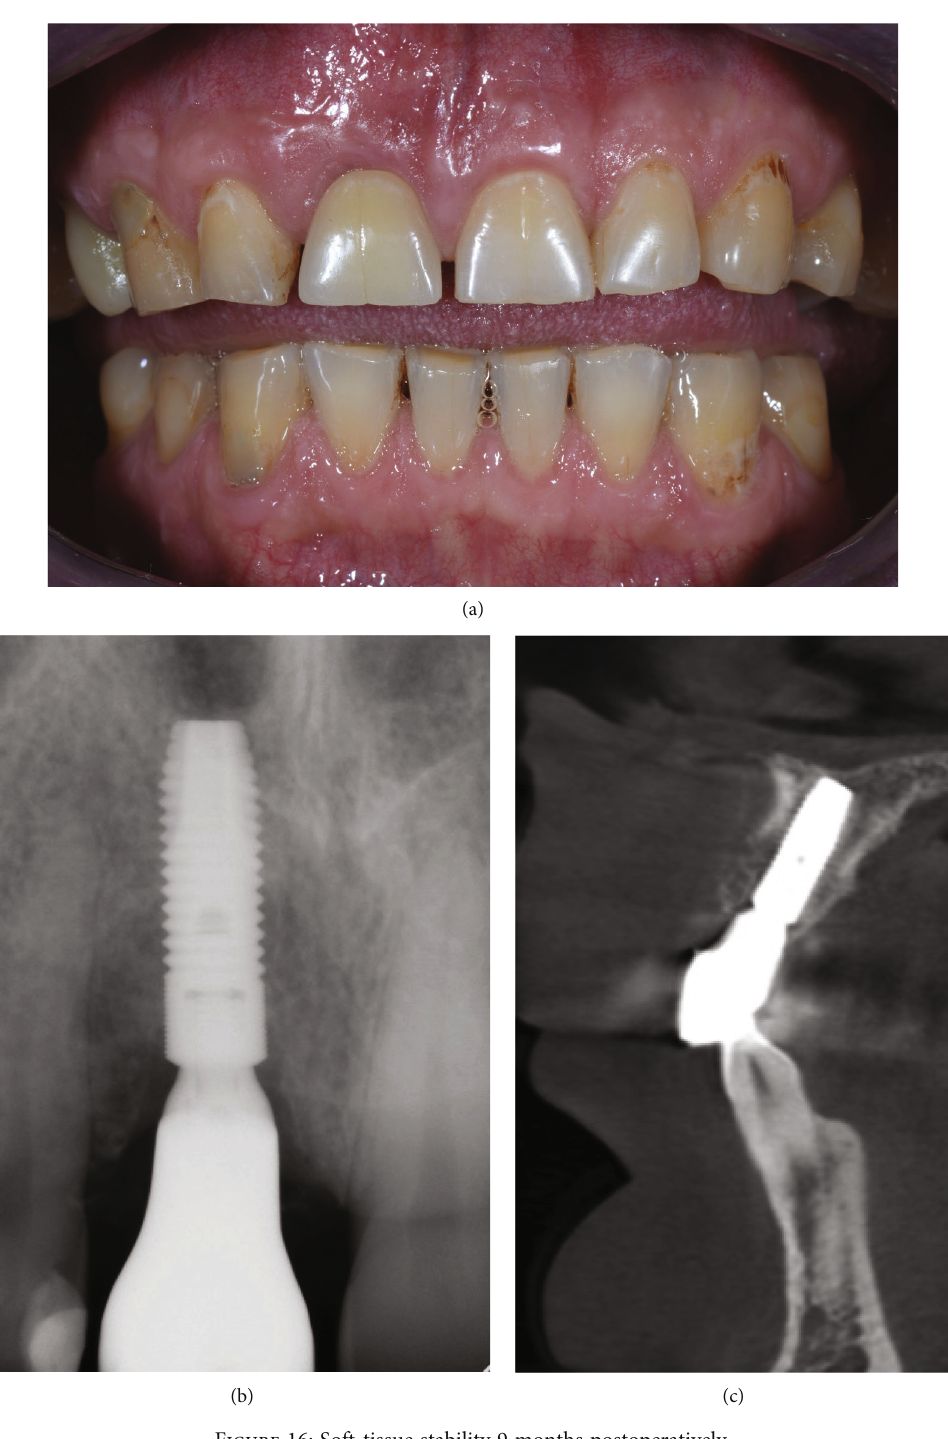
Figure 16: Soft-tissue stability 9 months